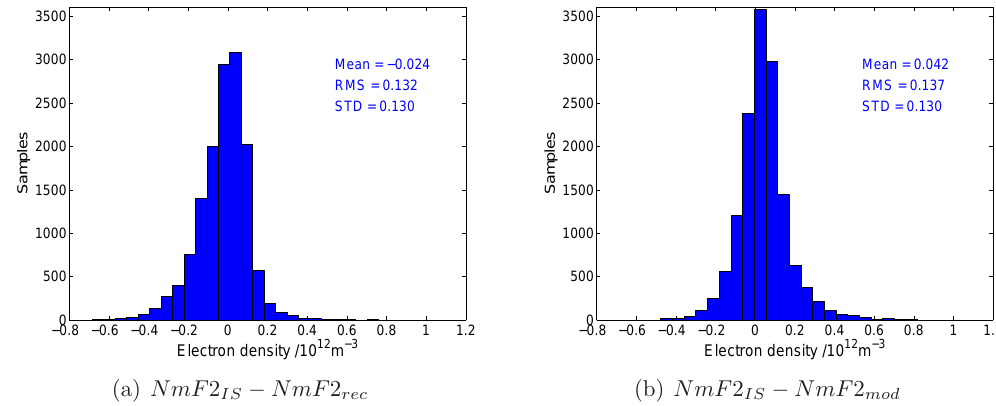
Fig. 6. Histograms of the residuals, July 2011. Reconstruction residuals are on the left side and model residuals on the right.